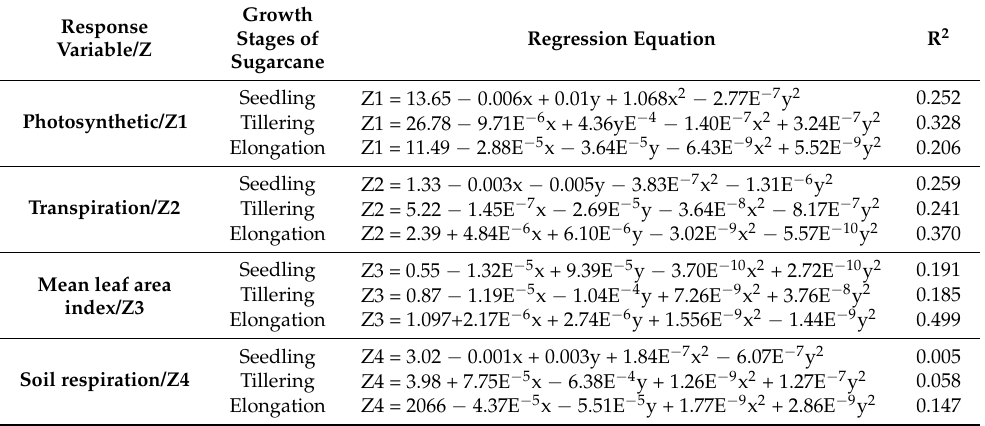
Table 5. Regression curves for photosynthesis, transpiration, leaf area index, and soil respiration at different growth stages of sugarcane under different water (x)-fertilizer (y) treatments.